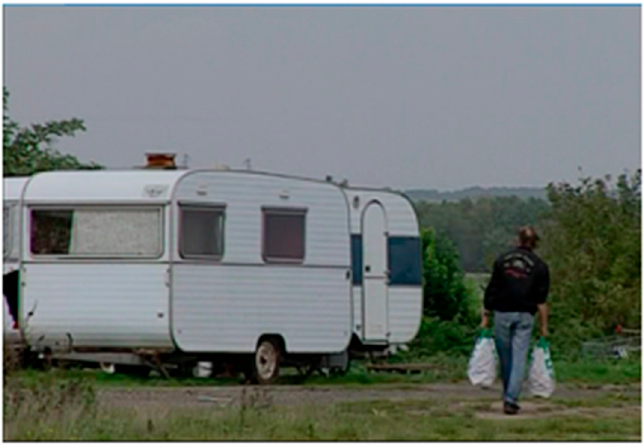
Figure 3. Trucks on the motorway, viewed from Varda’s car.